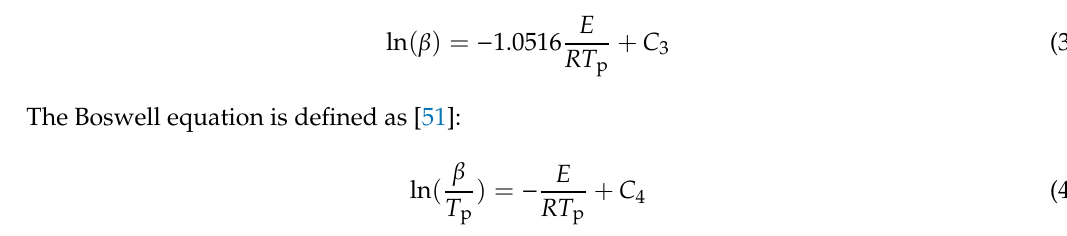
Table 6. The values of E p1 obtained using Kissinger, Moynihan, Ozawa, and Boswell methods.